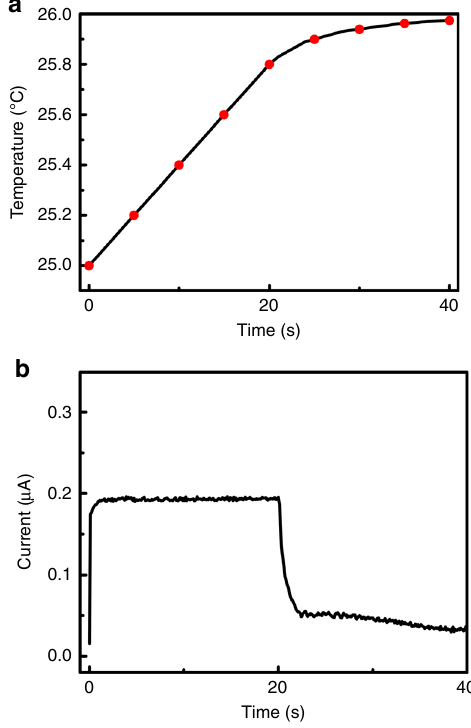
Fig. 4 Pyro-current measurement. a The temperature curve in a heating process. b The corresponding pyro-current